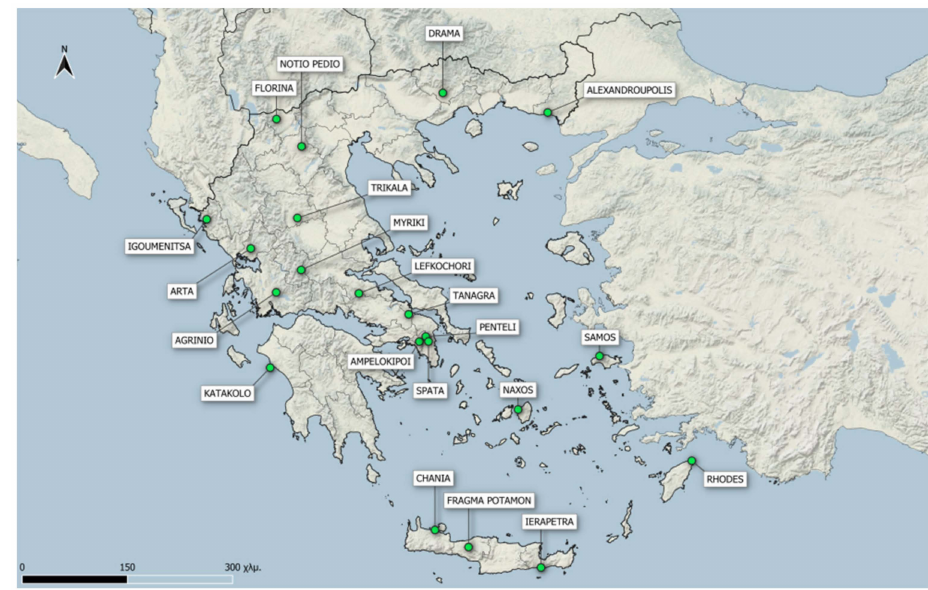
Figure 2. The network of meteorological stations used in this